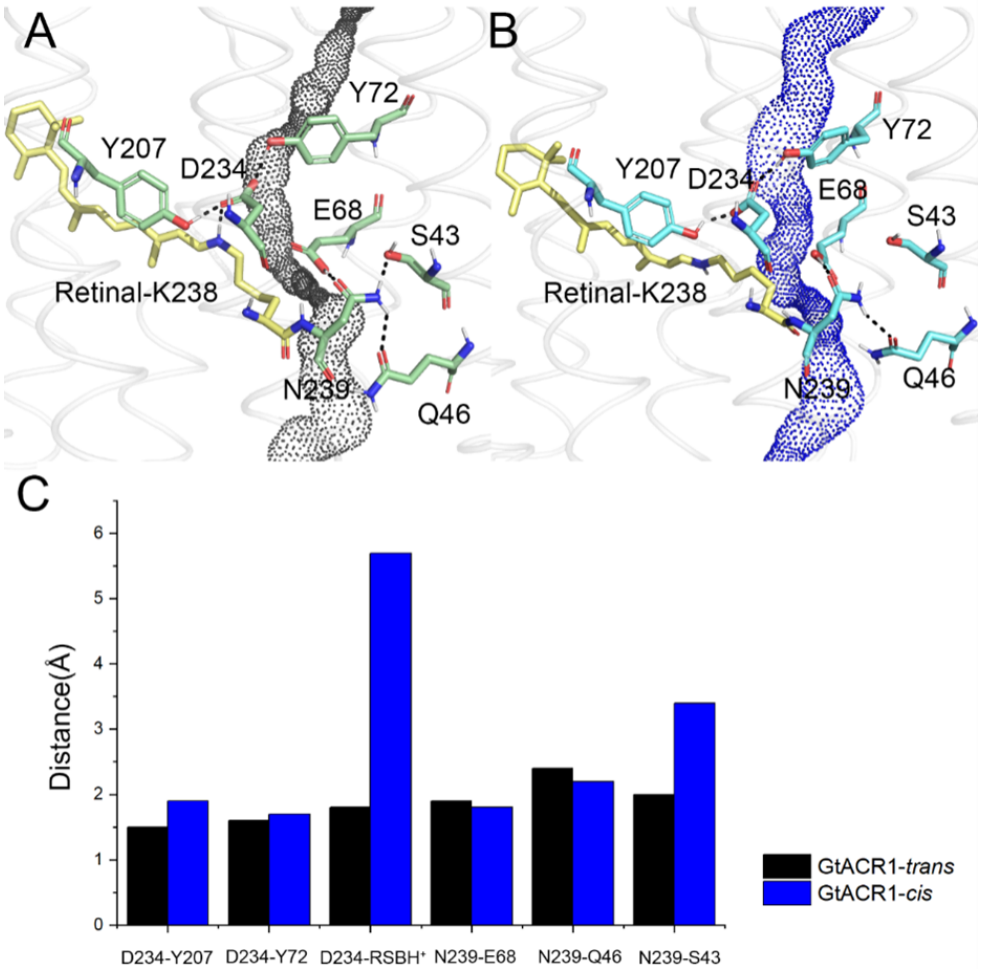
Figure 2. The local conformations near CCS1 of ( A ) GtACR1- trans and ( B ) GtACR1- cis . The profiles of the potential anion conductance pathway are represented by dots through CCS1 (E68, S43, Q46, N239). ( C ) Comparison of distances between residue pairs of CCS1 of trans and cis conformation of